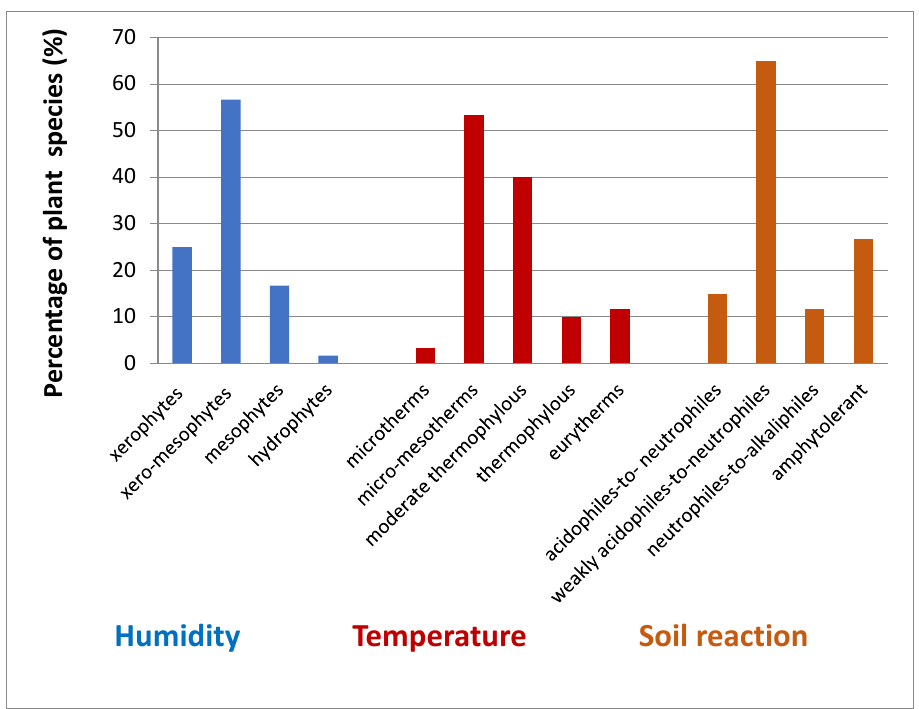
Temperature Soil reaction Figure 7. The ecological perspective of investigated vegetation in Natura 2000 ROSCI0238 Suatu– Cojocna–Crairat (Cojocna).